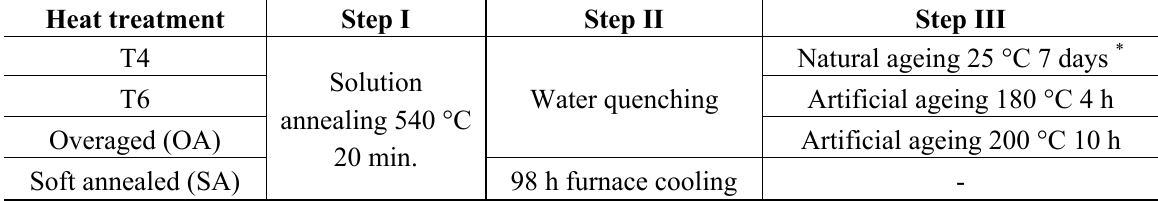
Table 2. Heat treatment parameters of the investigated